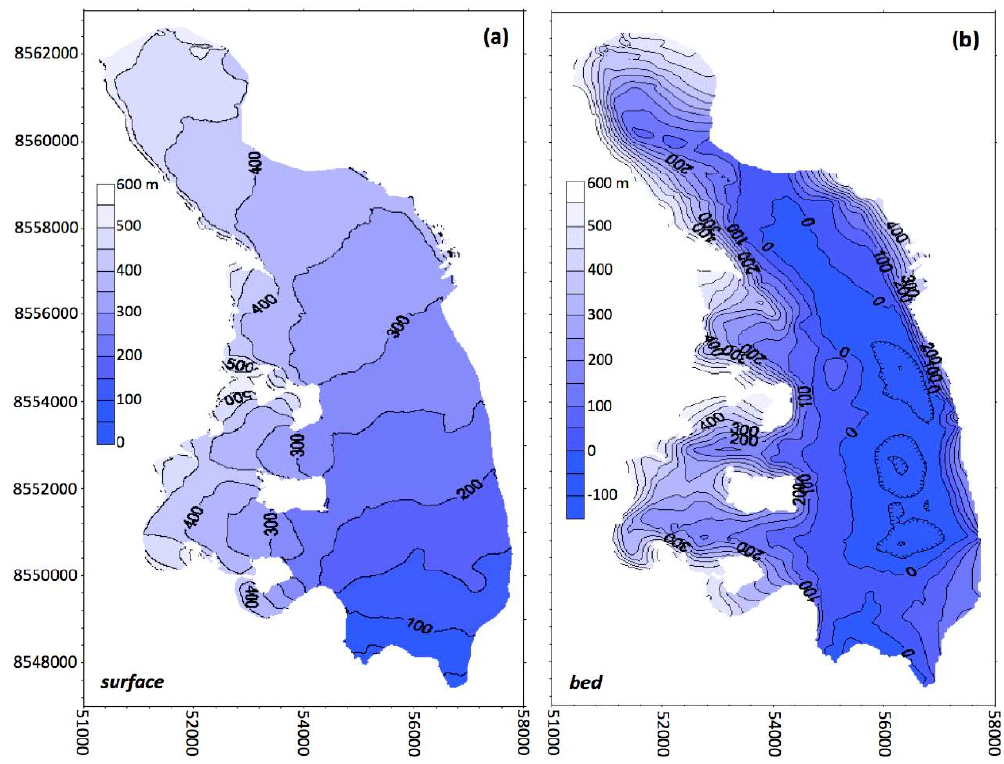
Fig. 2. Surface elevation (a) and bed topography (b) of Hansbreen (courtesy of Mariusz Grabiec, University of Silesia, personal communi- cation, 2010).